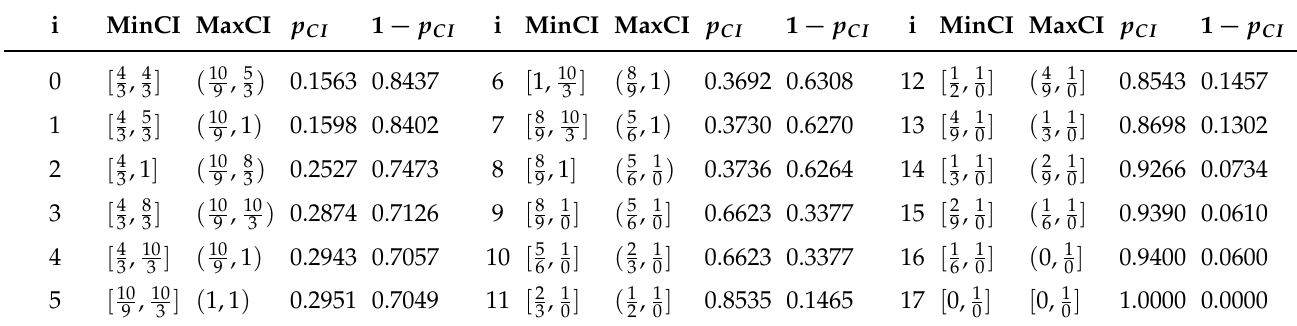
Table A8. Confidence intervals in increasing coverage for RR (data from Table